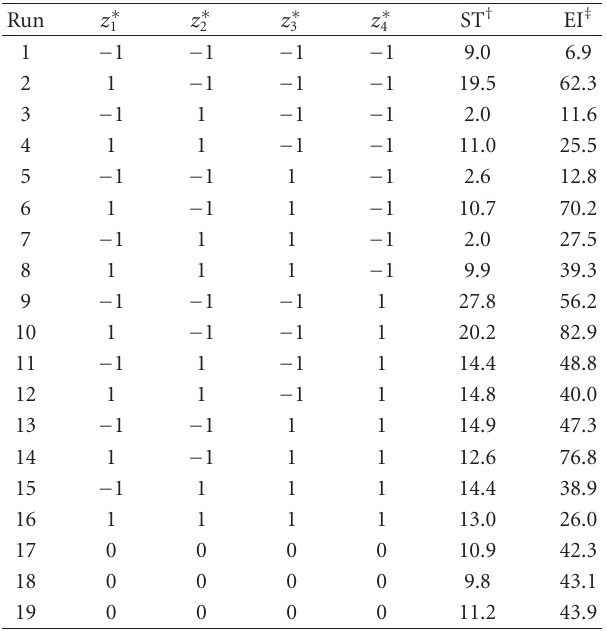
Table 4: Experimental design and results of the 2 4 full factorial design for carbon source analyses.